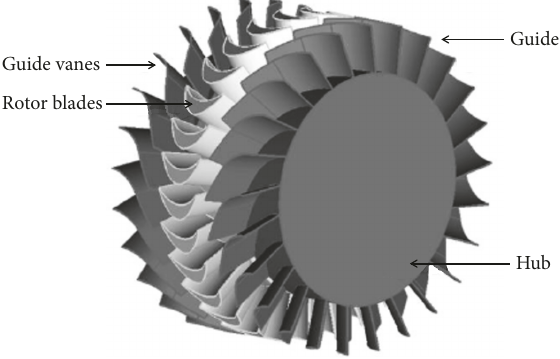
Figure 5: Impulse